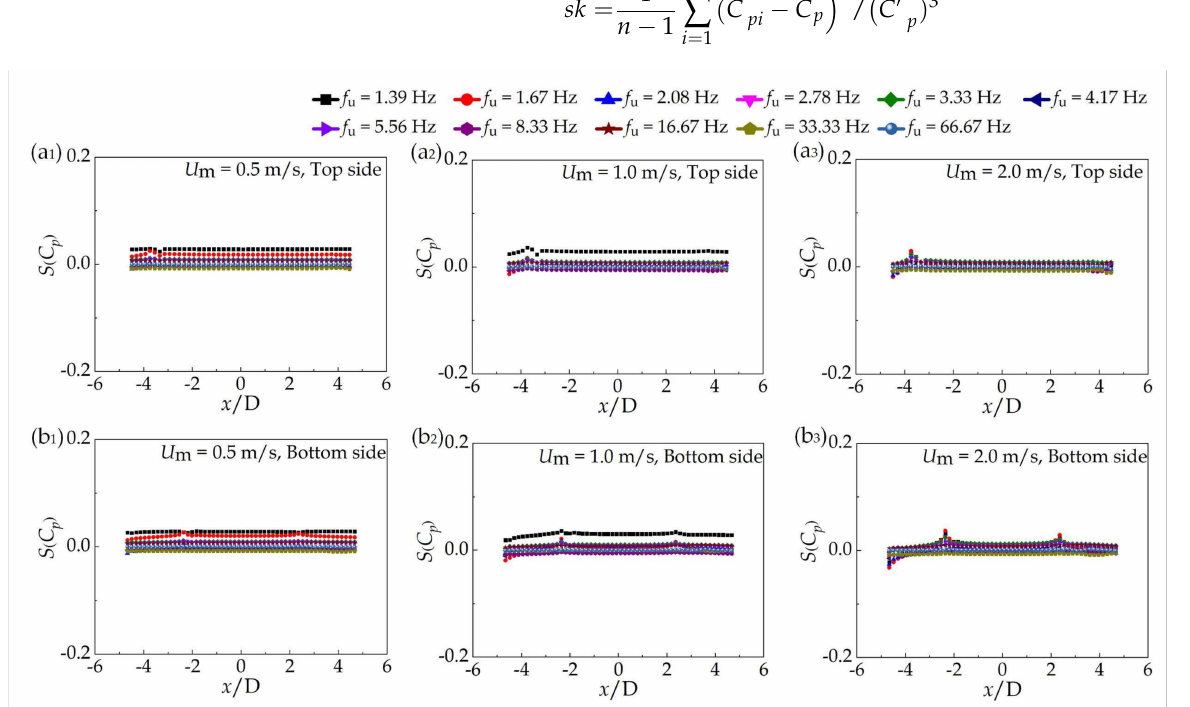
Figure 11. Skewness of pressure coefficients in the streamwise oscillating flows: ( a 1 ) U m = 0.5 m/s, top side; ( a 2 ) U m = 1.0 m/s, top side; ( a 3 ) U m = 2.0 m/s, top side; ( b 1 ) U m = 0.5 m/s, bottom side; ( b 2 ) U m = 1.0 m/s, bottom side; ( b 3 ) U m = 2.0 m/s, bottom